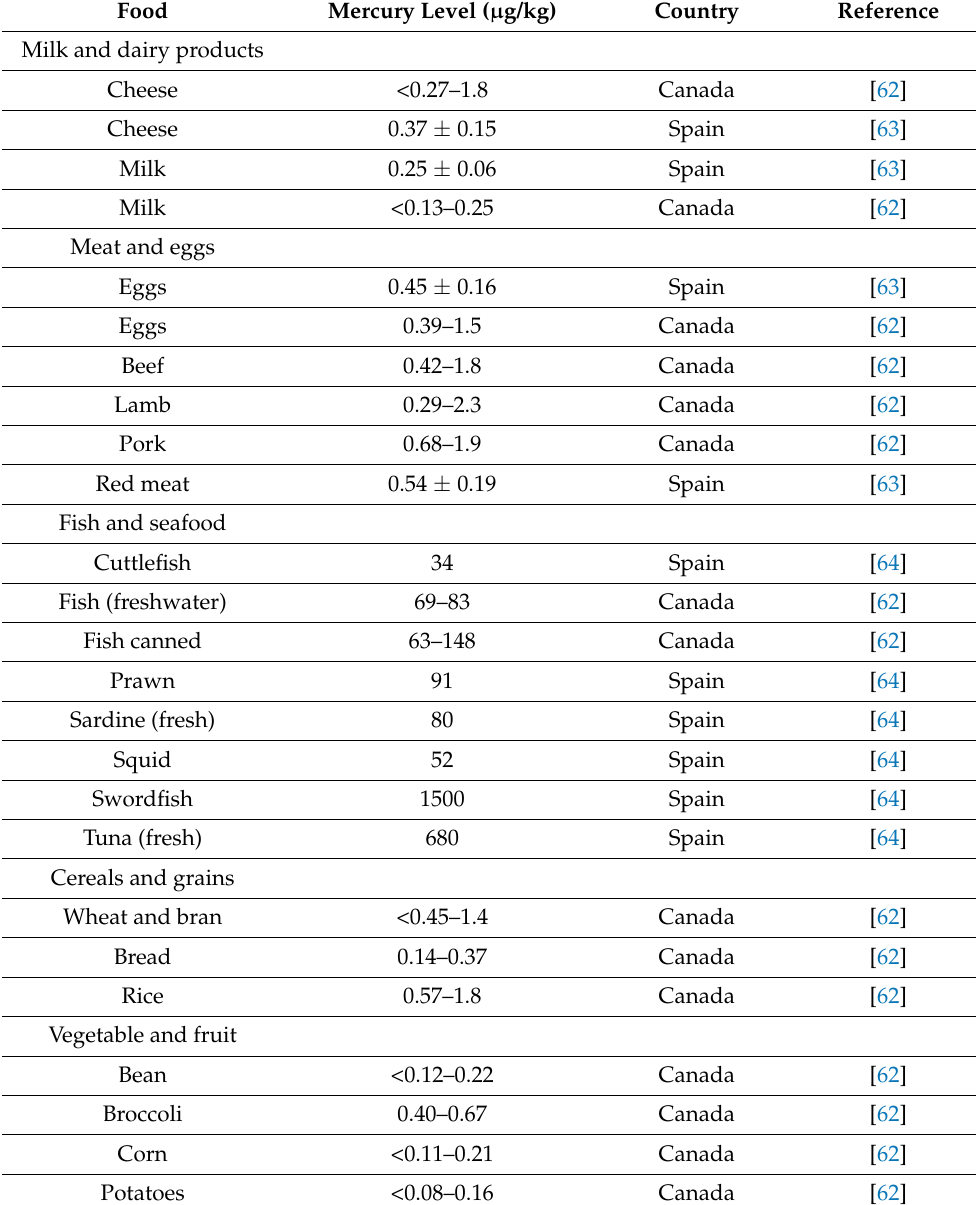
Table 3. Typical mercury levels in food from selected